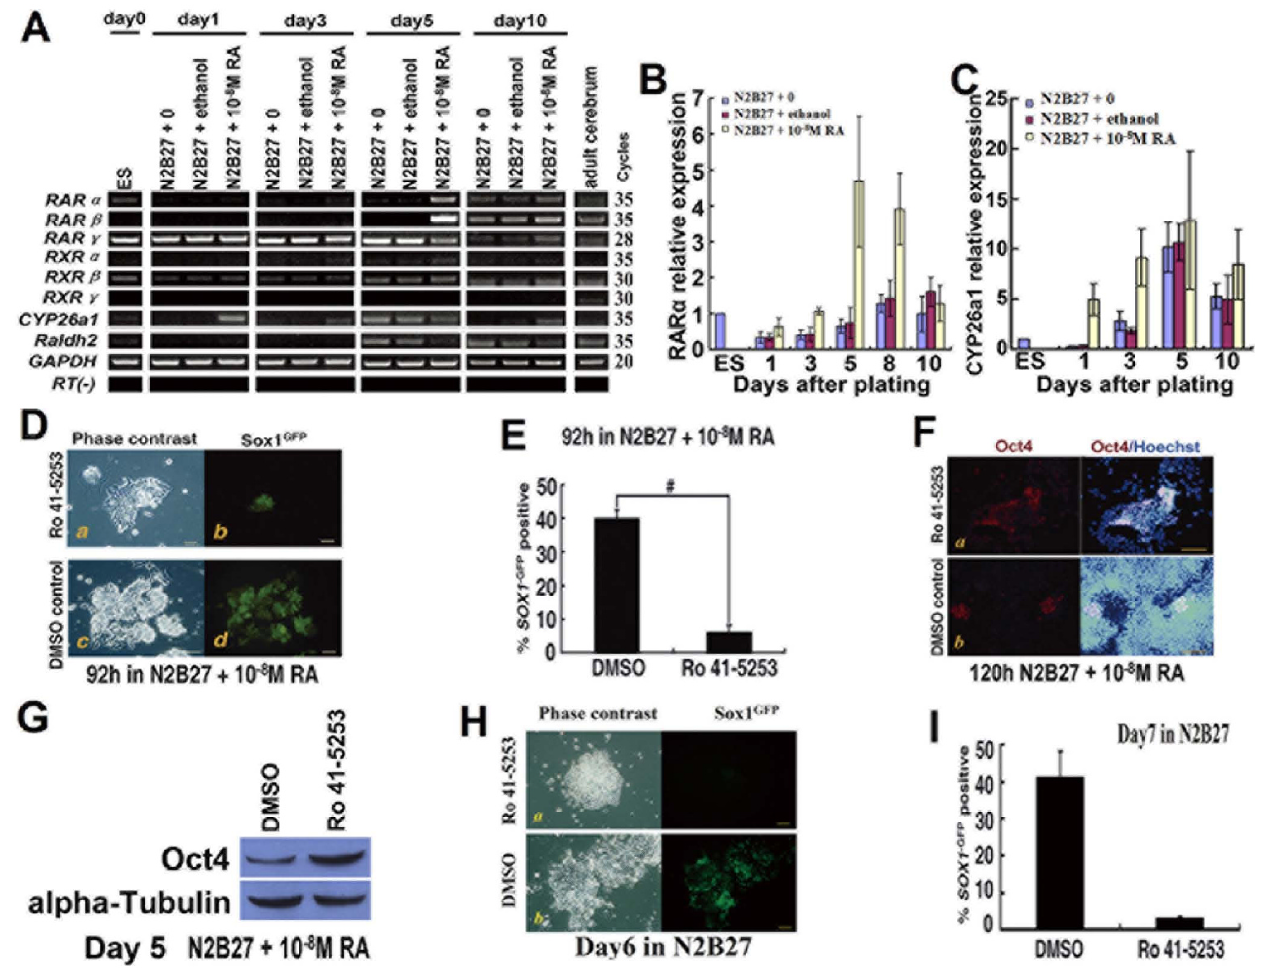
Figure 3 Requirement for RA signaling for efficient neural specification of ESCs . A , RT-PCR for RARs, RXRs and RA metab- olism-relative enzymes. RNA was isolated from ESCs (day 0), monolayer cultures (days 1, 3, 5 and 10) and adult mouse brain. Expression of RA nuclear receptors and two RA-metabolizing enzymes ( CYP26a1 and Raldh2 ) were analyzed by RT-PCR; B , C , Q-PCR for RAR α and CYP26a1 during monolayer differentiation; D-G , Monolayer differentiation of 46C ESCs in RA-treated cultures (N2B27 + 10 -8 M RA) exposed to 2 μ M RAR α inhibitor Ro 415253 or to equivalent amounts of DMSO diluents; D , Cultures of monolayer differentiation, shown in phase contrast or stained for Sox1 GFP ; E , Percentage of Sox1 GFP + cells scored by FACS. #, significant difference between inhibitor-treated cultures and DMSO-treated cultures (p < 0.001); F , Cultures of monolayer differentiation, shown in stained for Oct4 or combination of Oct4 and Hoechst; G , Western blot analysis of Oct4 at day 5 under monolayer cultures; H, I , Monolayer differentiation of 46C ESCs in cultures without RA (N2B27) exposed to 2 μ M RAR α inhibitor Ro 415253 or to equivalent amounts of DMSO diluents at Day6; H , Cultures of monolayer differentiation, shown in phase contrast or stained for Sox1 GFP ; I , Percentage of Sox1 GFP + cells scored by FACS; Scale bars: D, 40 μ m; F, H, 80 μ